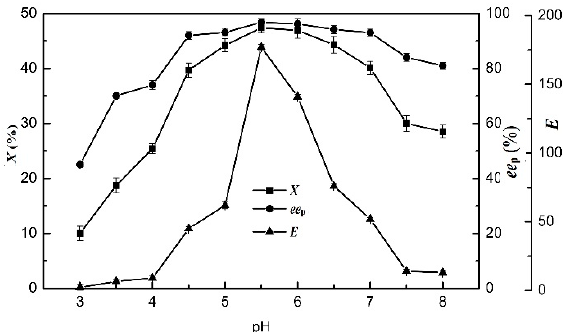
Figure 4. Effect of pH (from 3 to 8) on the degree of conversion, enantiomeric excess of product and enantioselectivity of EST10 using [OmPy][BF 4 ] as a co-solvent in the presence of enzyme EST10 (15 mg/mL) at 75 °C. The concentration of racemic ibuprofen ethyl ester was 2.5 mg/mL. The values are means of three independent experiments.